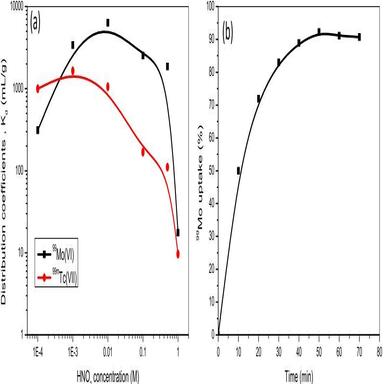
Sorption effect Mo(VI) and Tc(VII) from nitric acid onto mesoporous (MnO2/MWCNTs) sorbent (a) Kd values of 99Mo and 99mTc ions at different concentrations of HNO3 (b) Uptake of 99Mo ions on as a function of time.